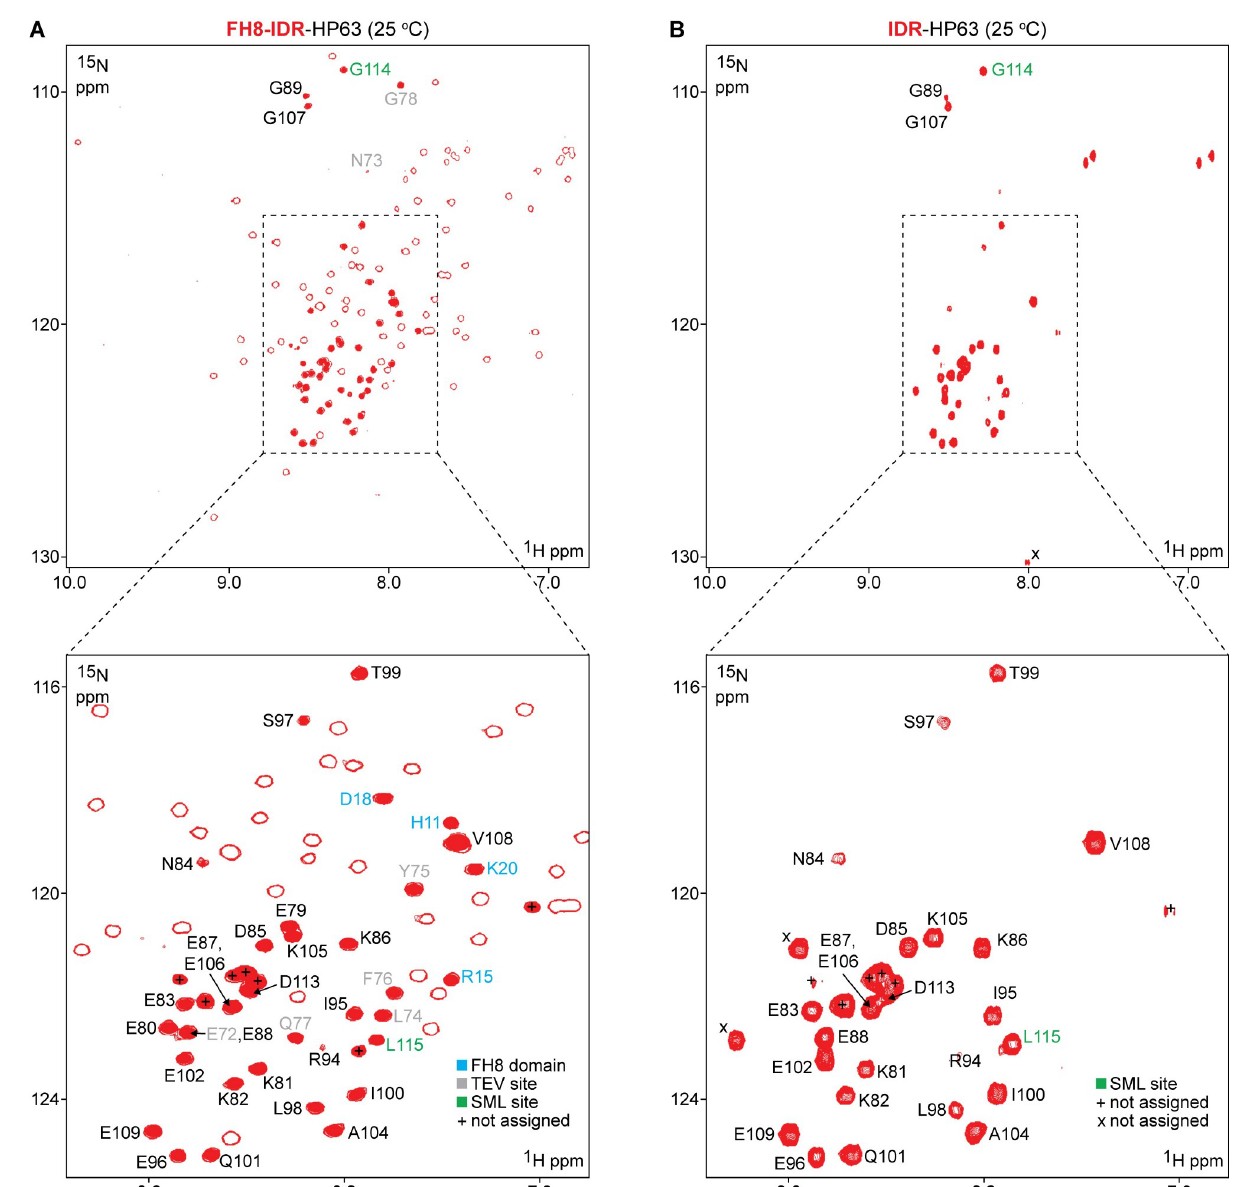
Fig 5. 15 N-HSQC NMR spectra (25˚C) of segmentally labeled FH8-IDR-HP63 and IDR-HP63. (A) Spectrum recorded at 600 MHz ( 1 H frequency) with 256 indirect increments using a FH8-IDR-HP63 sample with the FH8-IDR portion segmentally labeled with 13 C/ 15 N isotopes. All observed resonances for the labeled FH8-IDR segment are represented by open red contours, and signals that have been segmentally assigned to the IDR linker portion are overlaid with solid red ovals. Residue-specific NMR assignments for 36 residues in the linker region (27 from the villin 4 IDR and 9 residues from the flanking TEV and sortase ligation sites) and four FH8 domain peaks (false positives from the segmental assignment) are indicated with residue numbers. The numbers for the TEV site (7 residues) are shown in grey, FH8 domain (4 residues) are shown in blue, and two residues corresponding to the SML ligation site (G114, L115) are shown in green. Seven segmentally assigned peaks for which no residue specific assignments were obtained are marked with “+”. Residue numbers shown correspond to the sequence of FH8-IDR-HP63 (see S2 Fig ). To relate the assigned IDR residues to the corresponding positions in wild type villin 4, a value of 798 should be added. ( B ) Spectrum recorded at 500 MHz ( 1 H frequency) with 196 indirect increments using an IDR-HP63 sample with the IDR segmentally labeled with 15 N isotopes. All observed resonances for the labeled IDR segment are represented by solid red signals. Residue-specific NMR assignments for 25 residues in the linker region were unambiguously transferred from panel A (out of 27 listed on panel A ). Three new resonances were observed (marked with “x”) following removal of FH8. Two of these are presumed to correspond to residues E79 and E80, which are adjacent to the newly formed N-terminal residue G78. The two residues corresponding to the SML ligation site (G114, L115) are shown in green. As in the case of FH8-IDR-HP63 (panel A ), additional peaks (6 total) for which no residue specific assignments were obtained are marked with